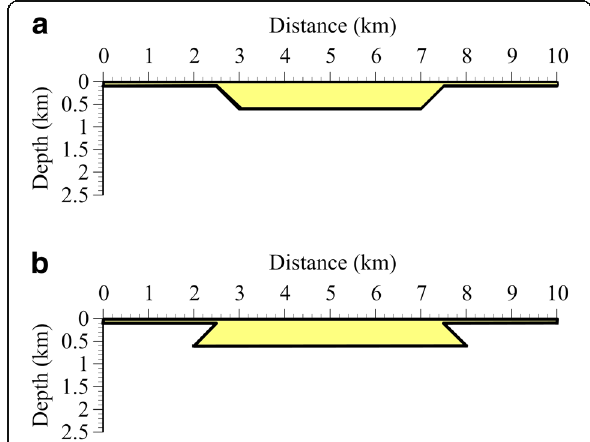
Fig. 5 Simplified sedimentary basin model. Light yellow and white areas indicate sedimentary layer and basement, respectively. a Sedimentary basin model where sedimentary layer is in contact with the basement by normal faults of 45° dip. b Sedimentary basin model where the sedimentary layer is in contact with the basement by reverse faults of 45° dip